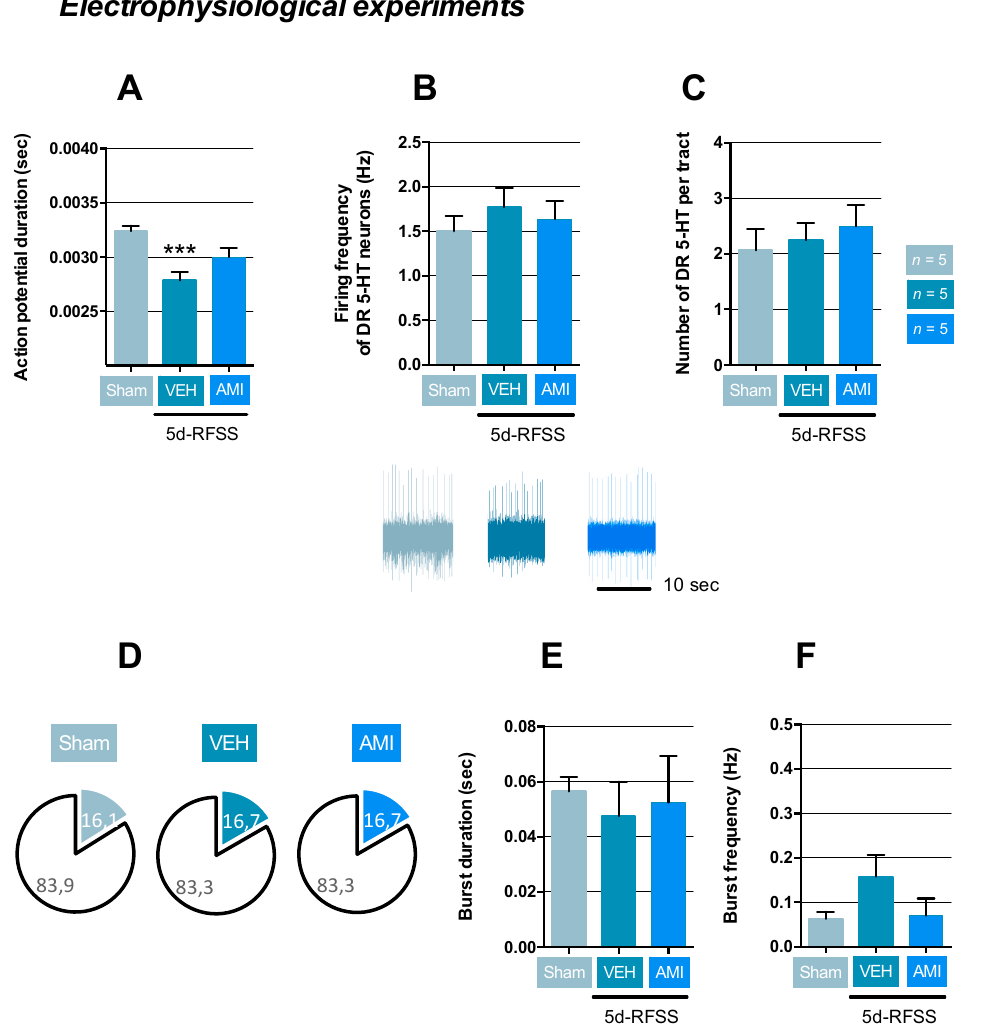
Figure 4. Impact of 5d-RFSS on the activity of dorsal raphe (DR) 5-HT neuronal activity in C57BL/6J mice. ( A – C ) Data are means ± SEM of the action potential duration (sec), the firing rate (in Hz), and the number of DR 5-HT neurons recorded per tract using extracellular in vivo electrophysiology. One-way ANOVA showed a significant effect of treatment factor on action potential duration (F(2,95) = 10.17; p < 0.001) but not on the firing ( B ) (F(2,95) = 0.48; p = 0.61) and the number of cells encountered (F(2,40) = 0.34; p = 0.71). Examples of typical recordings DR 5-HT neurons obtain in control non-stressed (sham), 5-dRFSS/Veh, and 5d-RFSS/AMI are also depicted. *** p < 0.001: significantly different from control non-stressed mice (sham) using Fischer’s PLSD post-hoc test. n = 5 mice per group. ( D – F ) Electrophysiological properties of DR 5-HT neurons displaying burst activity. Percent of DR 5-HT neurons discharging in bursst ( D ). Data are means ± SEM of burst duration (s) ( E ) and frequency (Hz) ( F ). One-way ANOVA did not show significant effects of treatment factor on these parameters (F(2,12) = 0.29; p = 0.82] and (F(2,12) = 1.39; p = 0.28), respec- tively.